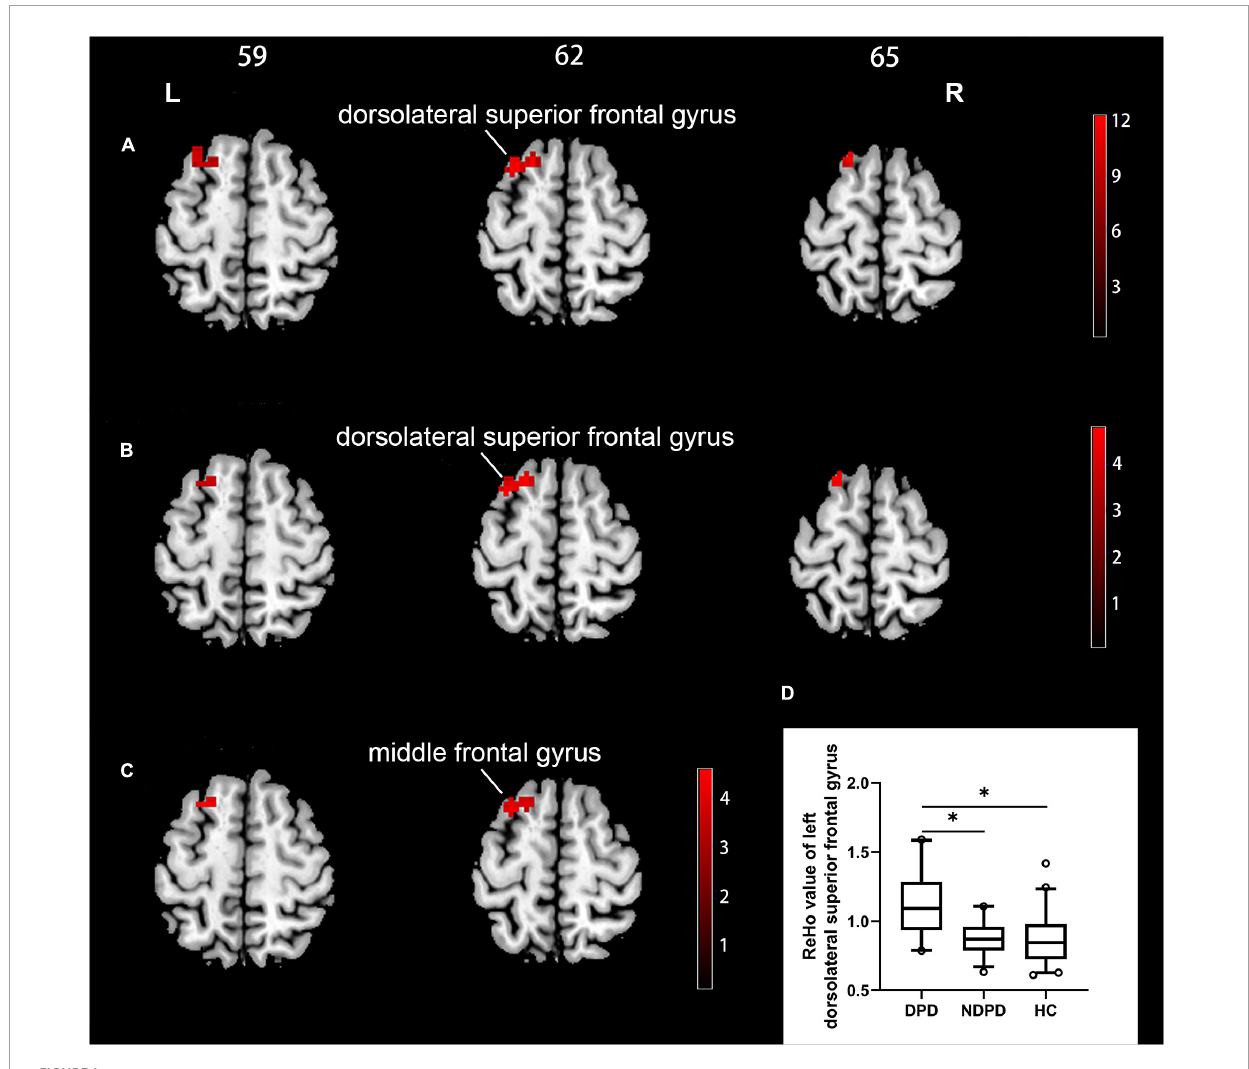
FIGURE1 Brain regions exhibiting significant differences in ReHo. (A) Group comparisons of the ReHo among DPD, NDPD, and HC groups. The color bar represents the F value of ANCOVA. (B) Post hoc analysis of DPD vs. NDPD. The color bar indicates the T -value from the two-sample t -test within the ANCOVA result masks. (C) Post hoc analysis of DPD vs. HC. The color bar indicates the T -value from the two-sample t -test within the ANCOVA result masks. (D) Box-and-whiskers plot for the ReHo value of the left dorsolateral superior frontal gyrus in DPD, NDPD, and HC groups. The boxes display the median and the 25th and 75th quartiles, whiskers showing the 5th and the 95th percentile. The outlier is shown as a data point outside of the box. ∗ Post hoc P -value < 0.05, Bonferroni corrected. L, left; R,